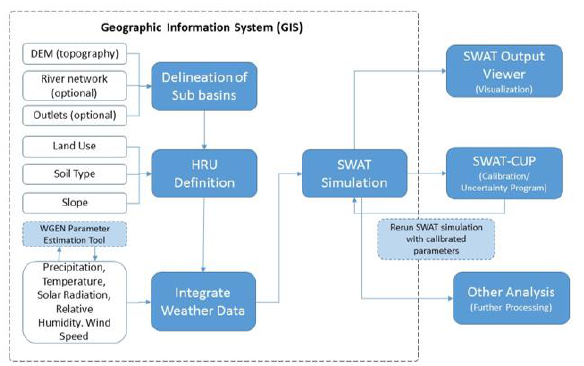
Figure 4 . General workflow of the study.